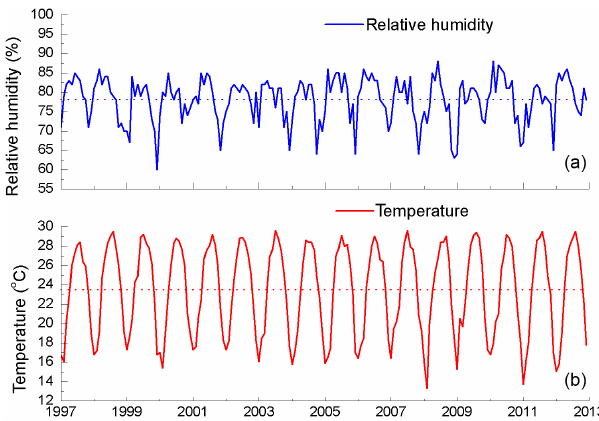
Figure 1. Statistics of relative humidity and temperature of Hong Kong from 1997 to 2012; dashed lines represent the average levels of RH and T (data were obtained from the Hong Kong Observa-